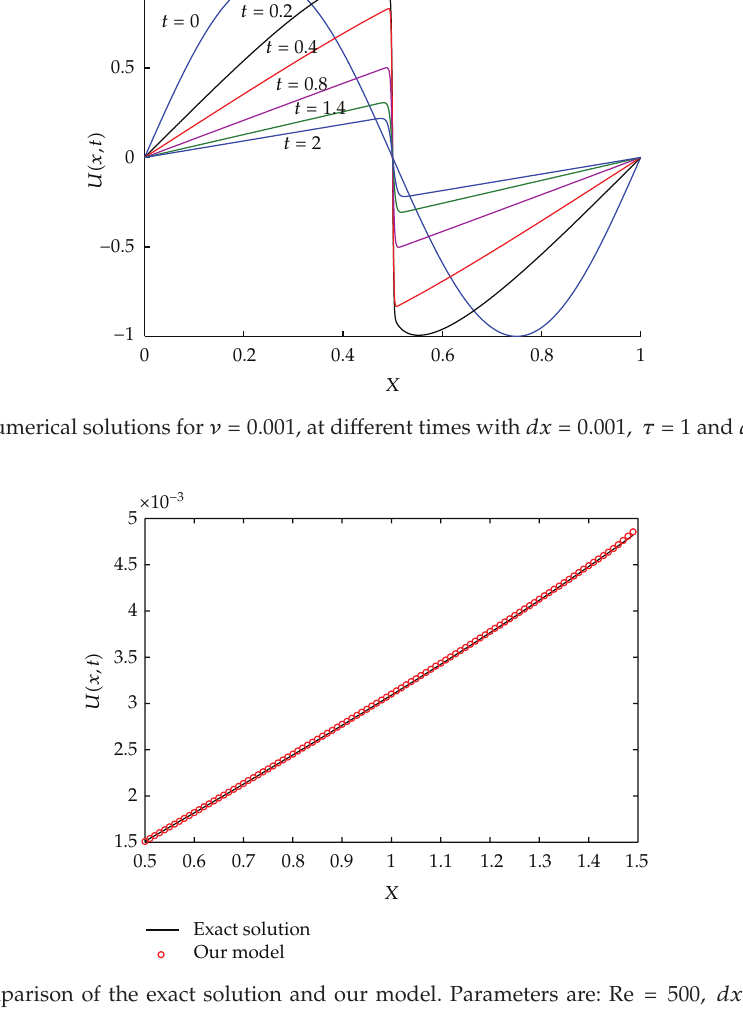
Figure 4: Comparison of the exact solution and our model. Parameters are: Re (cid:8) 500 , dx (cid:8) 0 . 01 , dt (cid:8) 0 . 002 ,τ (cid:8)